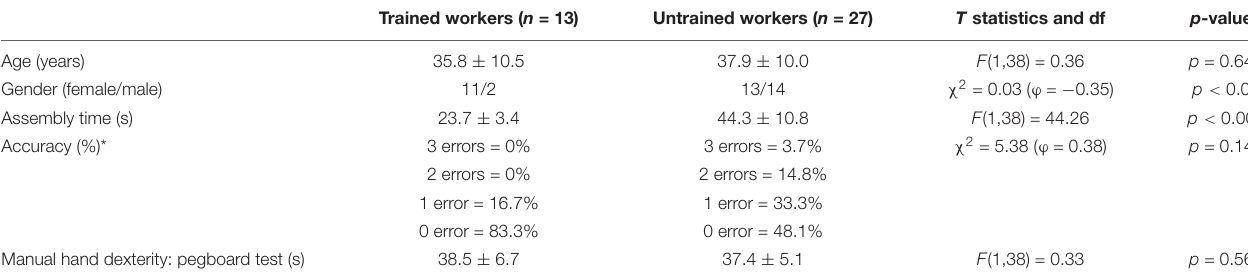
TABLE 1 | Participants’ characteristics.